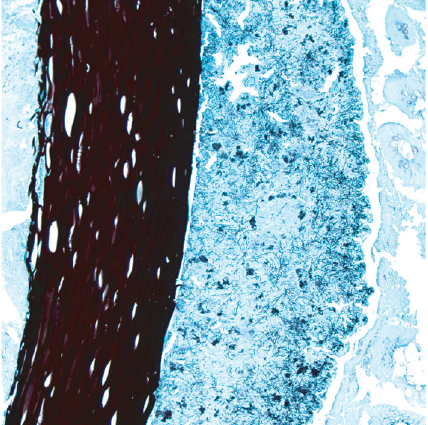
Figure 2: Grocott ’ s methenamine silver stain showing Actinomyces species (10x).